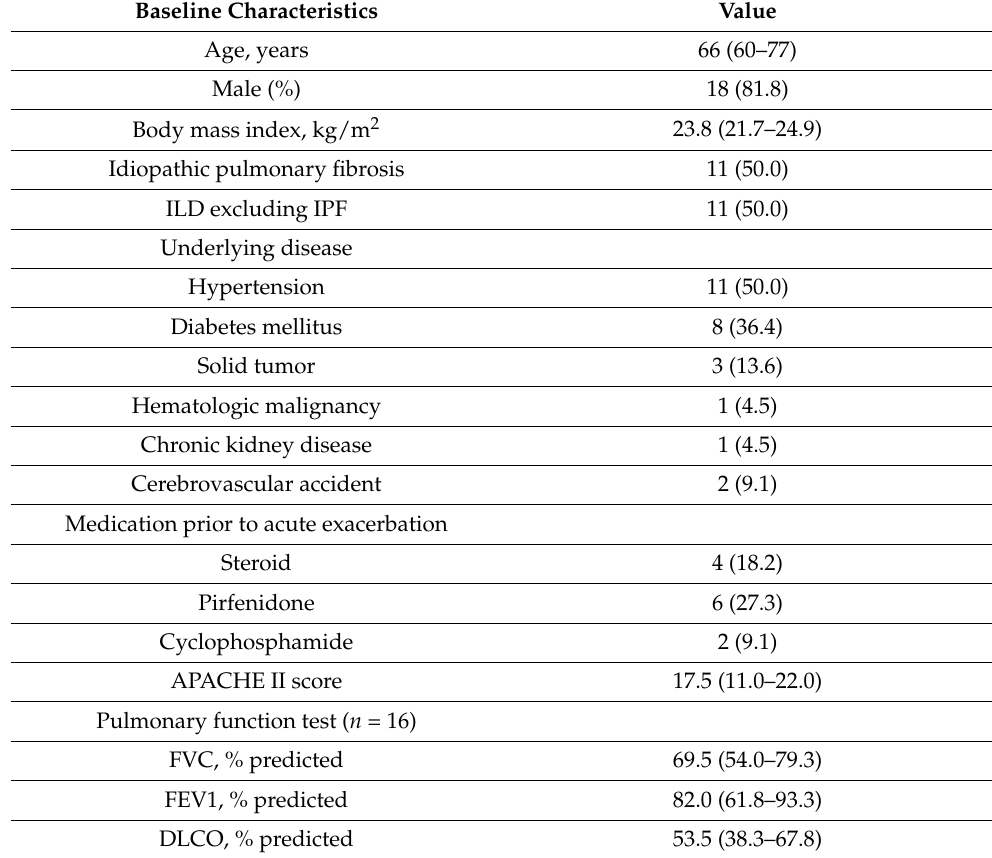
Table 1. Baseline characteristics of the